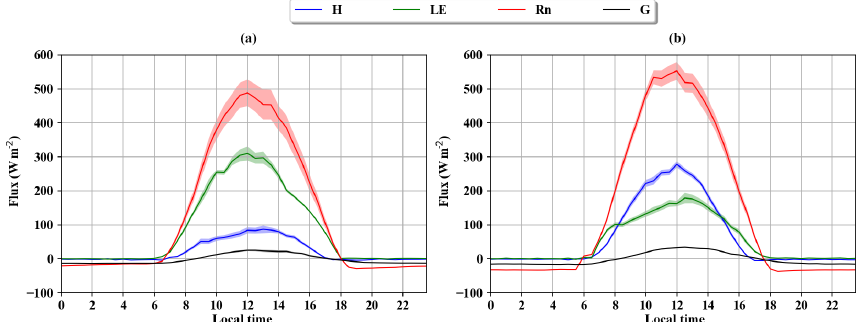
Figure 5. Average of the daily cycle of net radiation ( R n ) (Wm − 2 ), sensible heat flux ( H ) (Wm − 2 ), latent heat flux ( LE ) (Wm − 2 ) and soil